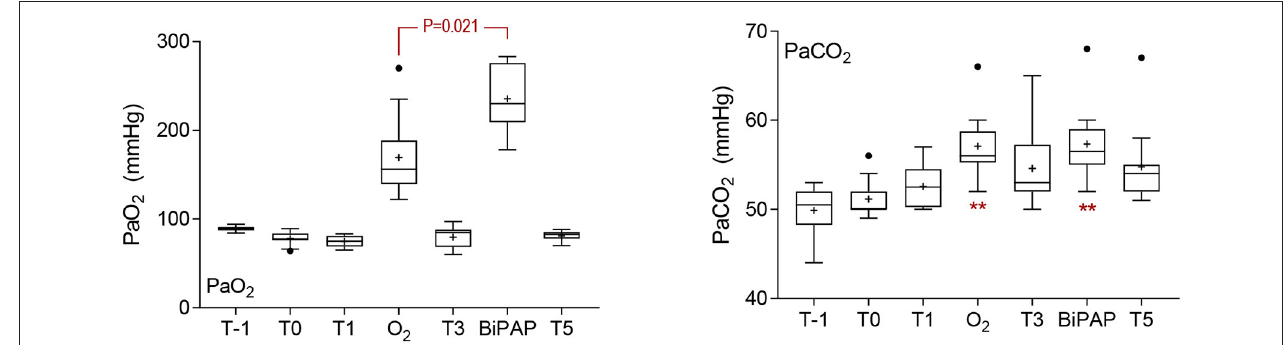
FIGURE 1 | Blood gas results. Sedation was associated with a significant decrease in PaO 2 at T0 ( P = 0.002) and T1 ( P = 0.004). The administration of supplementary oxygen by mask (O 2 ) or during bi-level positive airway pressure ventilation (BiPAP) was associated with a significant increase in PaO 2 (both P < 0.001), and results following BiPAP were significantly greater than following O 2 , as indicated. Results for arterial CO 2 pressures were not normally distributed, and were resistant to transformation. Results following O 2 and BiPAP were significantly greater than results at T-1 and T0, as shown (** P < 0.001), following analysis by